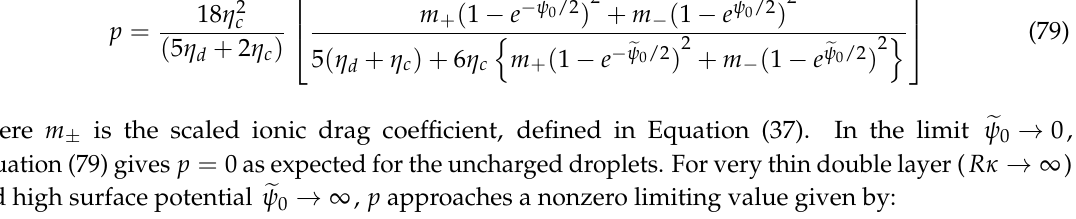
Figure 21. Primary electroviscous coefficient p versus 0